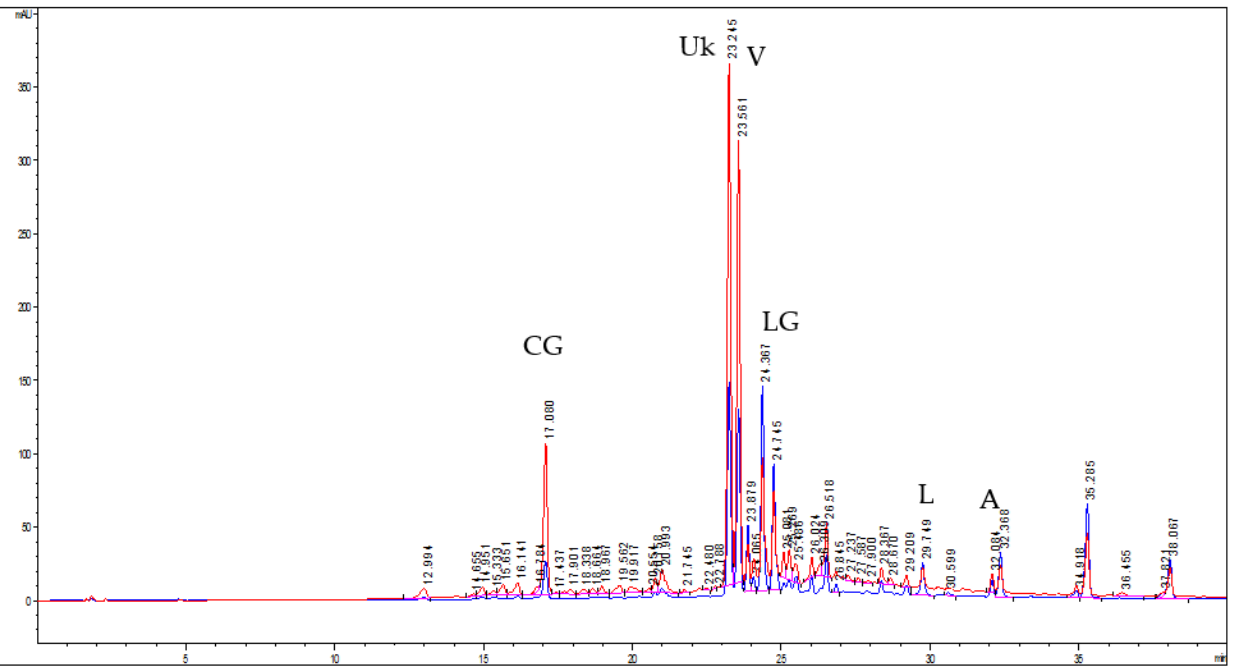
Figure 1. Chromatograms at 313 nm (red line) and 360 nm (blue line) of T. marum extract obtained by ultrasound-assisted maceration in ethanol and water (70:30), where the peaks of chlorogenic acid (CGA), unknown (Uk), verbascoside (V), luteolin-7-O-glucoside(LG), luteolin (L), apigenin (A) are presented.